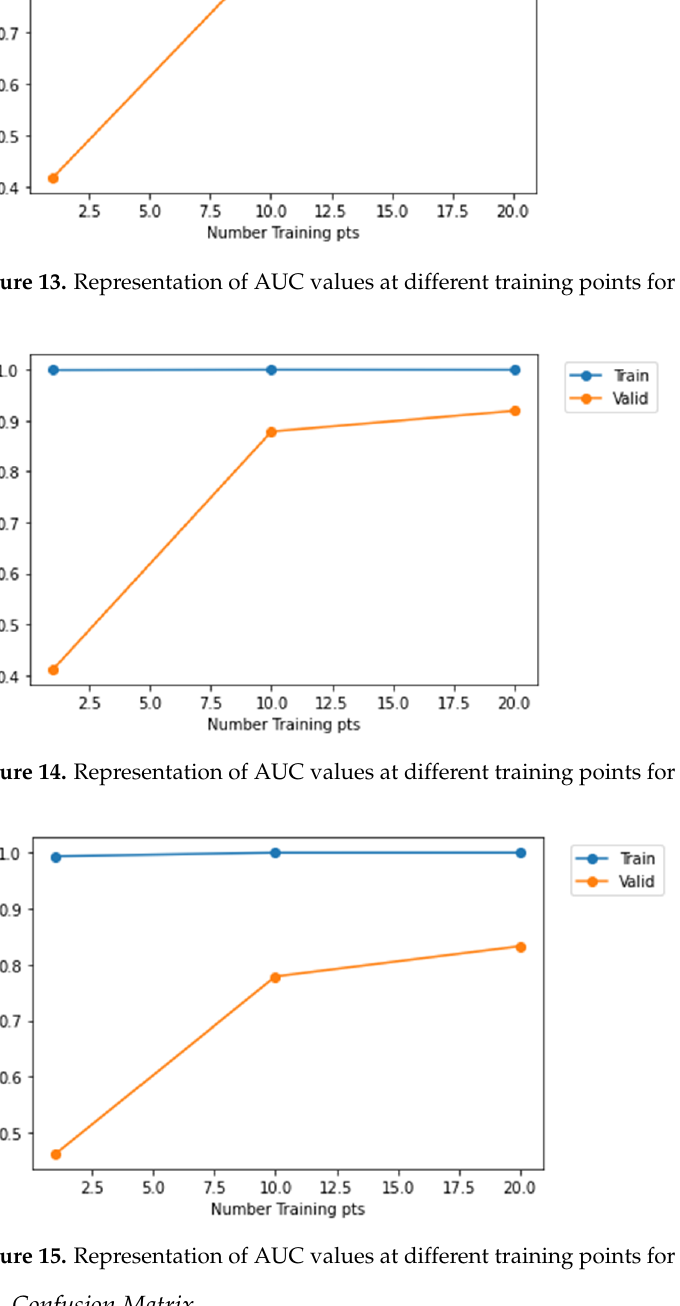
Figure 15. Representation of AUC values at different training points for Model-3.